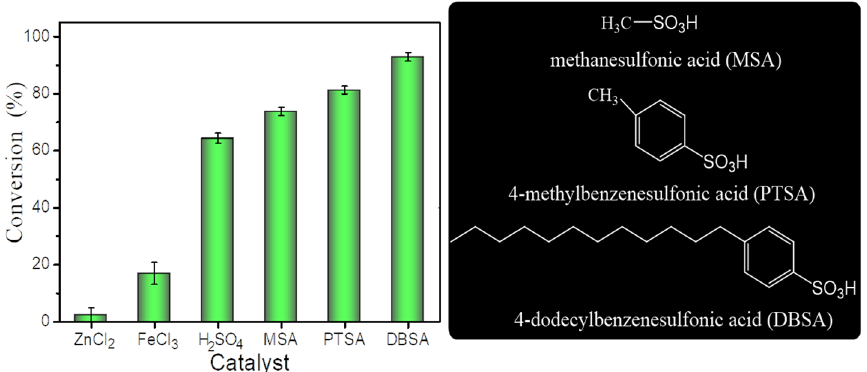
Figure 1. Synthesis of cetyl oleate through esterification.